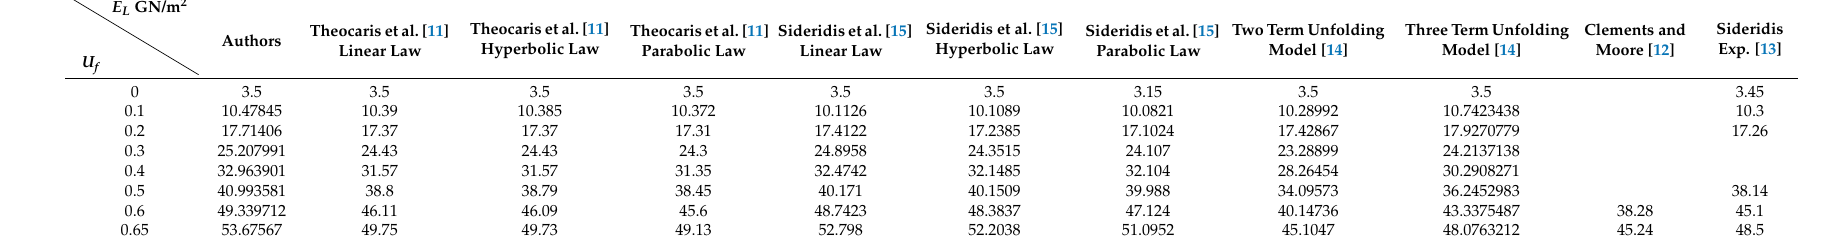
Table 1. Theoretical and experimental values of longitudinal modulus with respect to fibre